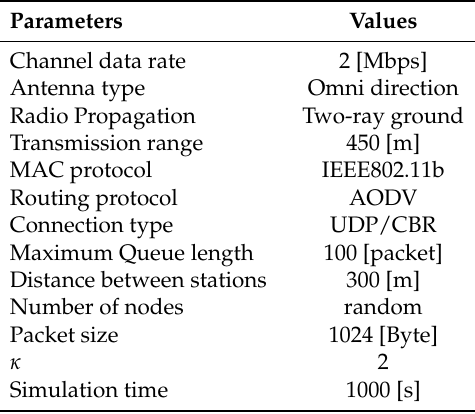
Table 1. The simulation